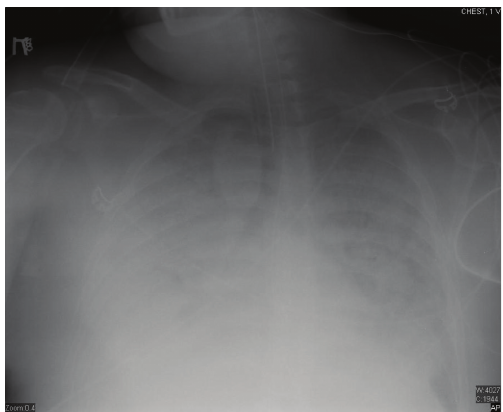
Figure 3: Chest X-ray day 22 after chemotherapy (ANC was 11,500 cell/ µ L).